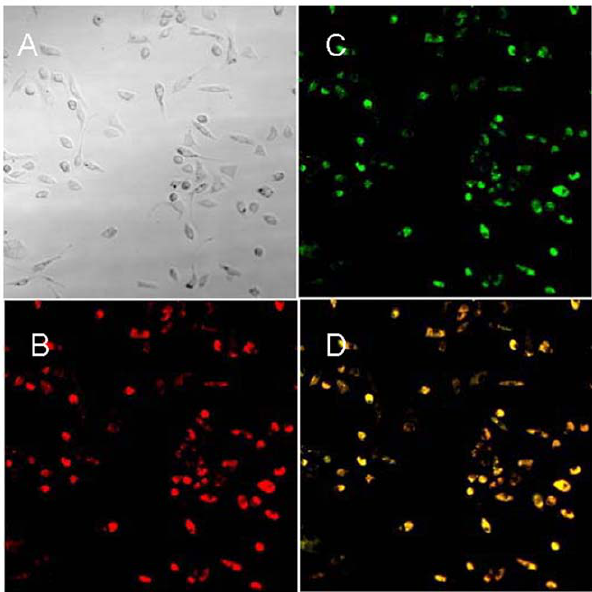
Figure 3. Endothelial cell characteristics. After 7 days culture (A), cells taken up DiI-ac-LDL were red fluorescence (B), bound to FITC-UEA-I displayed green fluorescence (C), and the double-stained cells showed yellow fluorescence in cytoplasm (D). (Magnification 6 200).